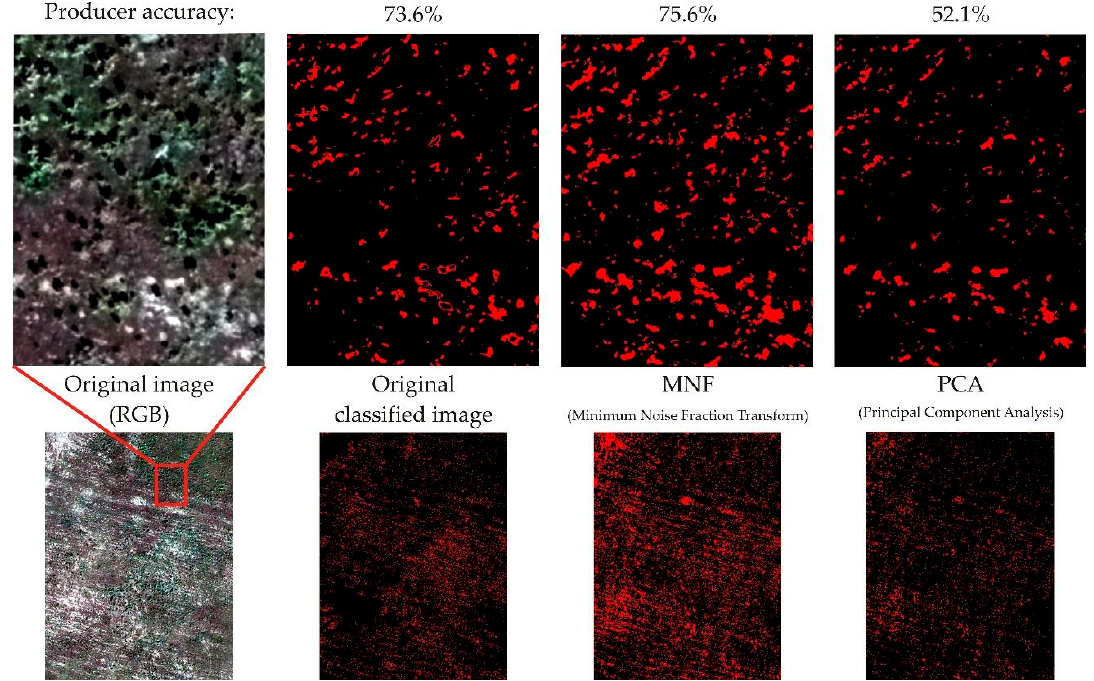
Figure 5. Results of SVM classification on a smaller section of the study area.